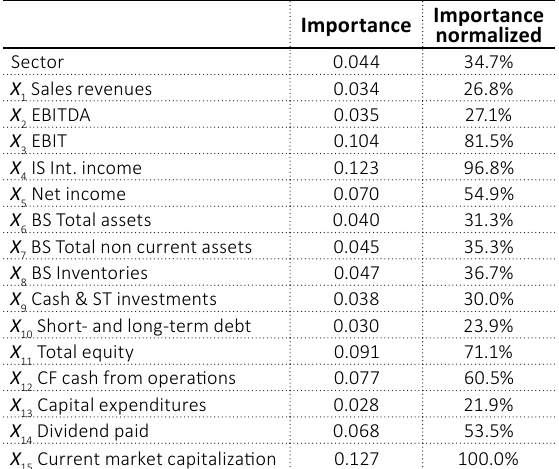
Table 12. Classification with a network in three classes (sample I, S&P)